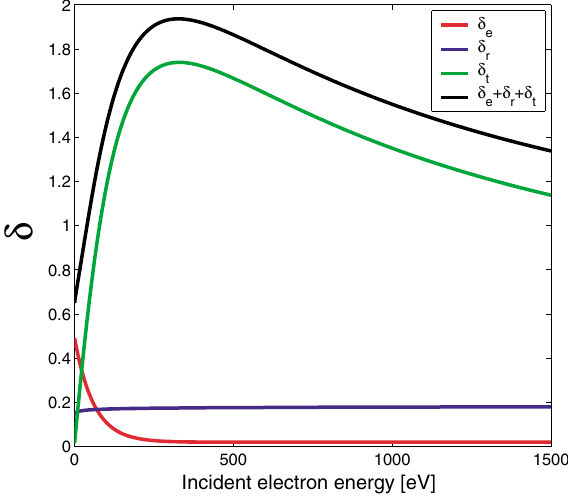
FIG. 3. (Color) Secondary emission yield.